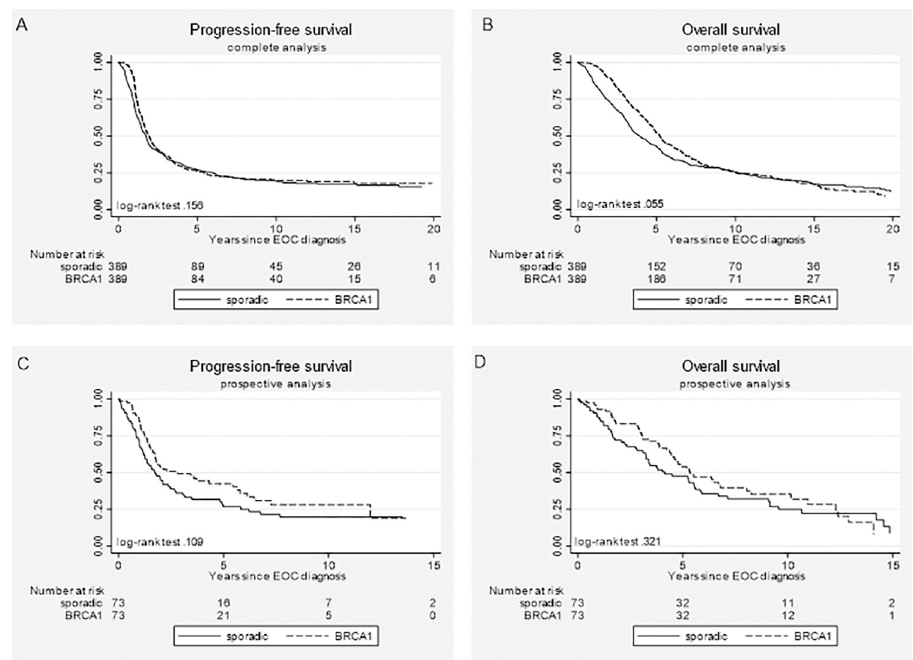
Fig 1. Kaplan-Meier survival curves for BRCA1- associated epithelial ovarian cancer (EOC) patients (dashed lines) and sporadic EOC patients (solid lines) treated with chemotherapy. (A) progression-free survival and (B) overall survival for the complete dataset; (C) progression-free survival and (D) overall survival for the prospective